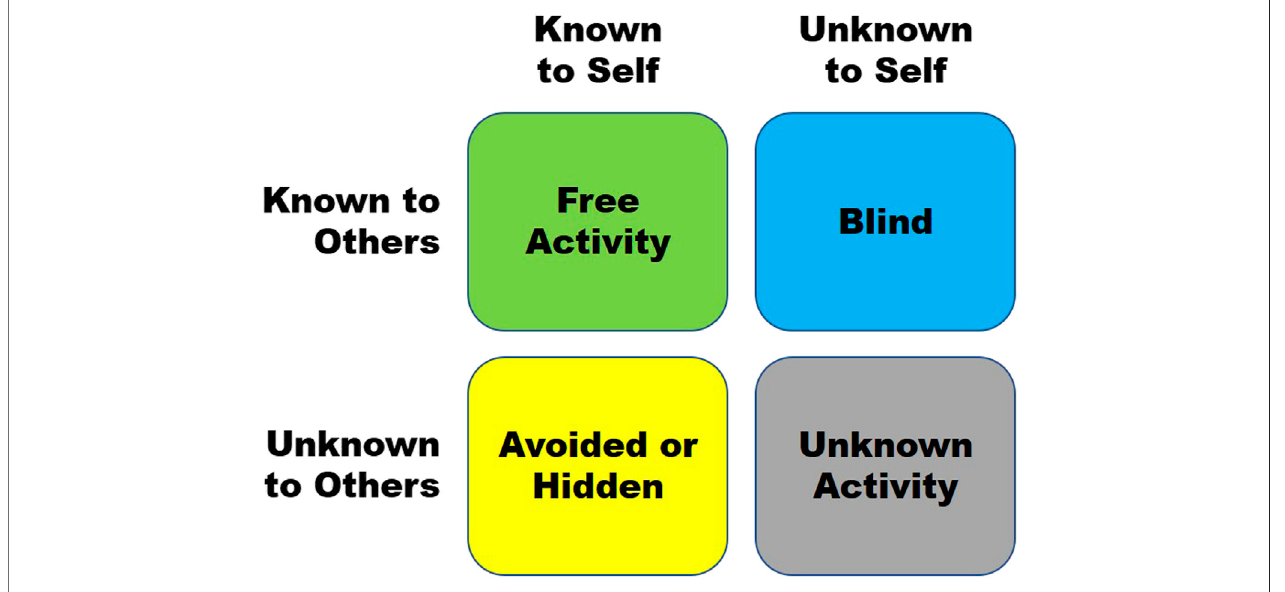
FIGURE 3 | Johari Window of